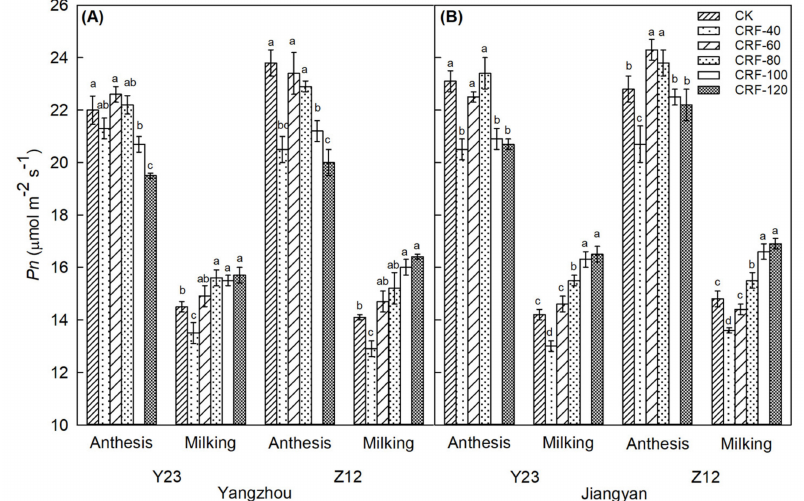
Figure 6. Net photosynthetic rate ( Pn ) in wheat flag leave at the anthesis and milking stages in different CRF treatments in Yangzhou ( A ) and Jiangyan ( B ) sites in 2018–2019. Error bars represent SE of the mean ( n = 6). Different lowercase letters above bars represent significant differences at 0.05 probability